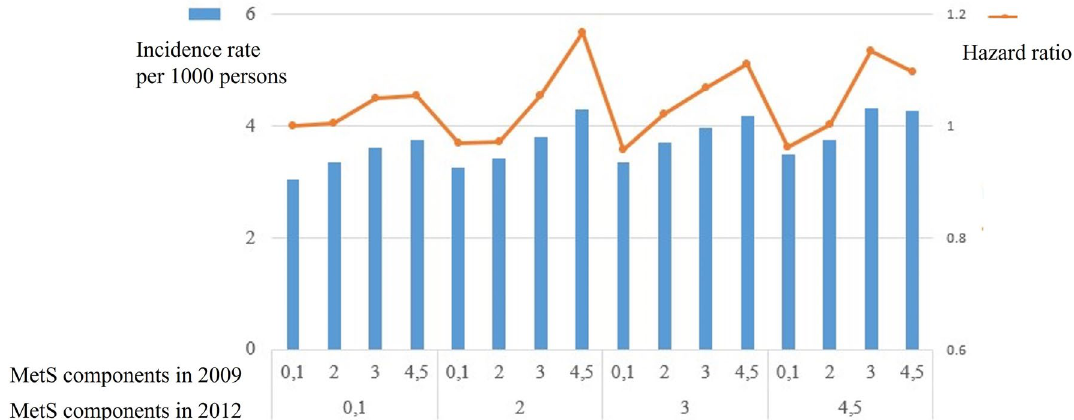
Figure 1. Relationship between change in the number of MetS components from first to second visits and the risk of psoriasis. The lower row of the x-axis represents the number of MetS components satisfied in 2009, and the upper row of the x-axis represents the number of MetS components satisfied in 2012. The blue bar graph with left y-axis represents incidence rate per 1000 persons with psoriasis. The orange line graph and right y-axis represent HR. Regardless of the number of MetS components in 2009, the incidence rate and HR of psoriasis increased according to number of MetS components in